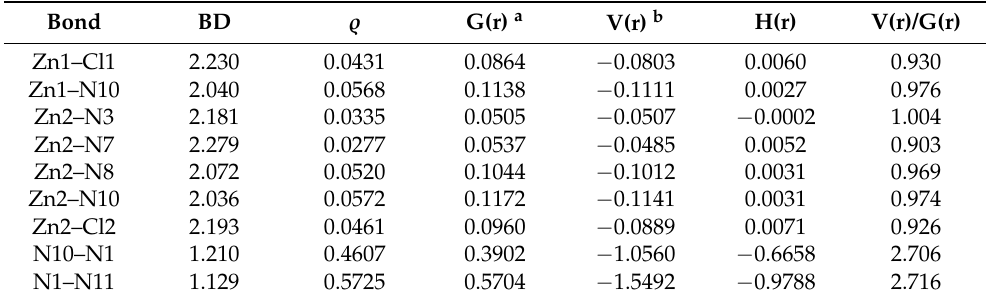
Table 3. AIM parameters (a.u.) for Zn–N and Zn–Cl bonds in the [Zn 3 (PMT) 2 (Cl 4 )(N 3 ) 2 ] complex.